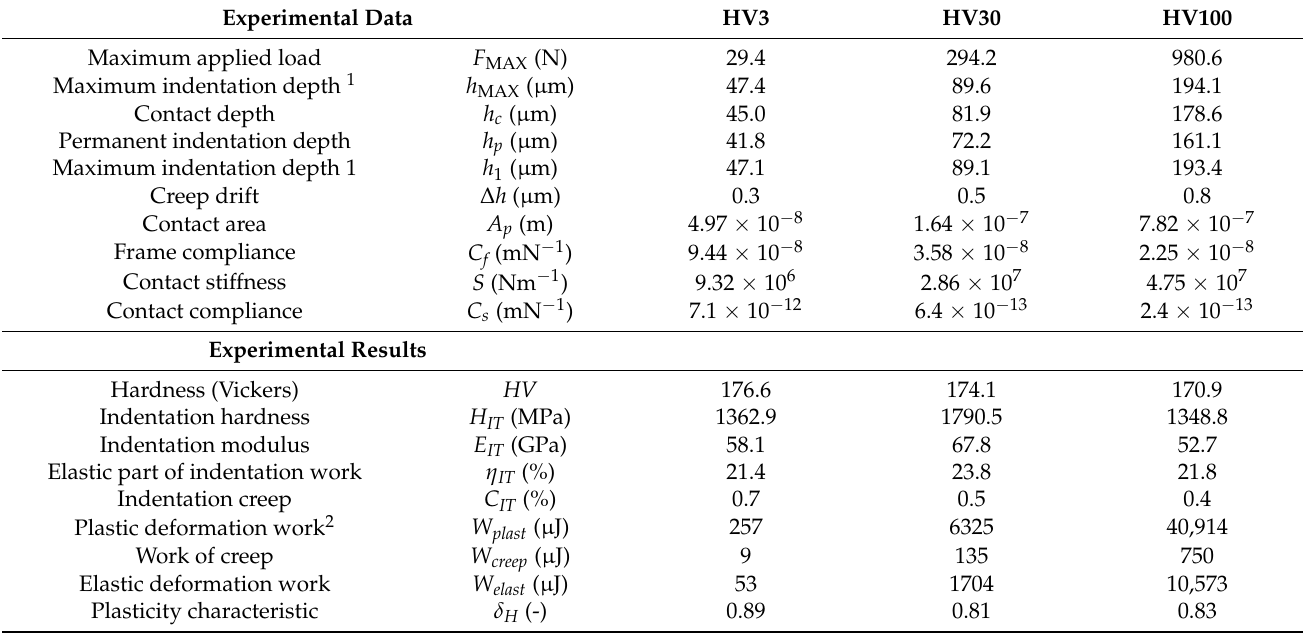
Table 4. Data of the HV test results on aluminum alloy.